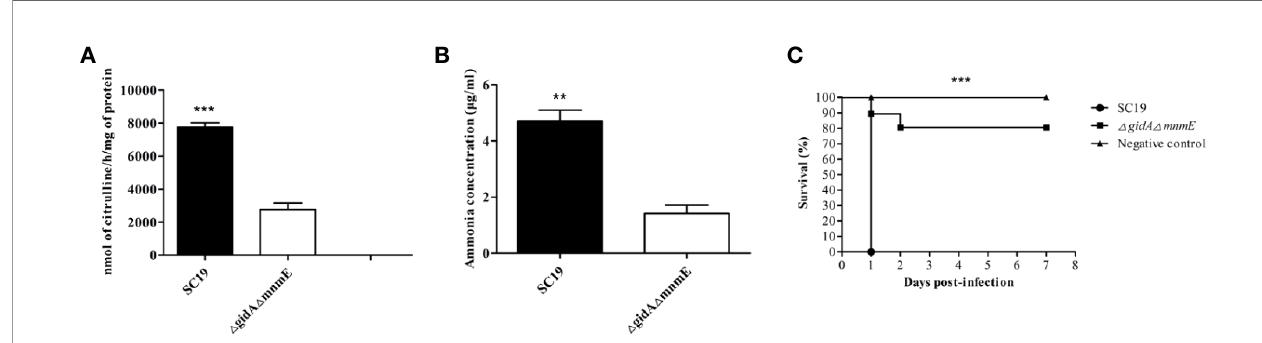
FIGURE 2 | Regulation of AD Activity, ammonia production and pathogenicity by GidA-MnmE pathway. (A) AD activities of SC19 and D gidA D mnmE . Results were expressed as nanomoles of citrulline produced per hour per milligram of whole cell protein. (B) Ammonia production of SC19 and D gidA D mnmE . Ammonia production in supernatant of SC19 and D gidA D mnmE are given as m g ammonia/ml. Data are presented as the mean ± SEM of three independent experiments. Statistical signi fi cance was determined by two-tailed t test (**, p < 0.01; ***, p < 0.001). (C) Survival curves for mice in infection experiment. Ten mice in each group were separately injected intraperitoneally with 3 × 10 9 CFU/mouse of SC19 or D gidA D mnmE . Ten mice were inoculated with saline and served as negative control. Signi fi cant difference in survival between different groups was analyzed by Log Rank test ( p < 0.001).